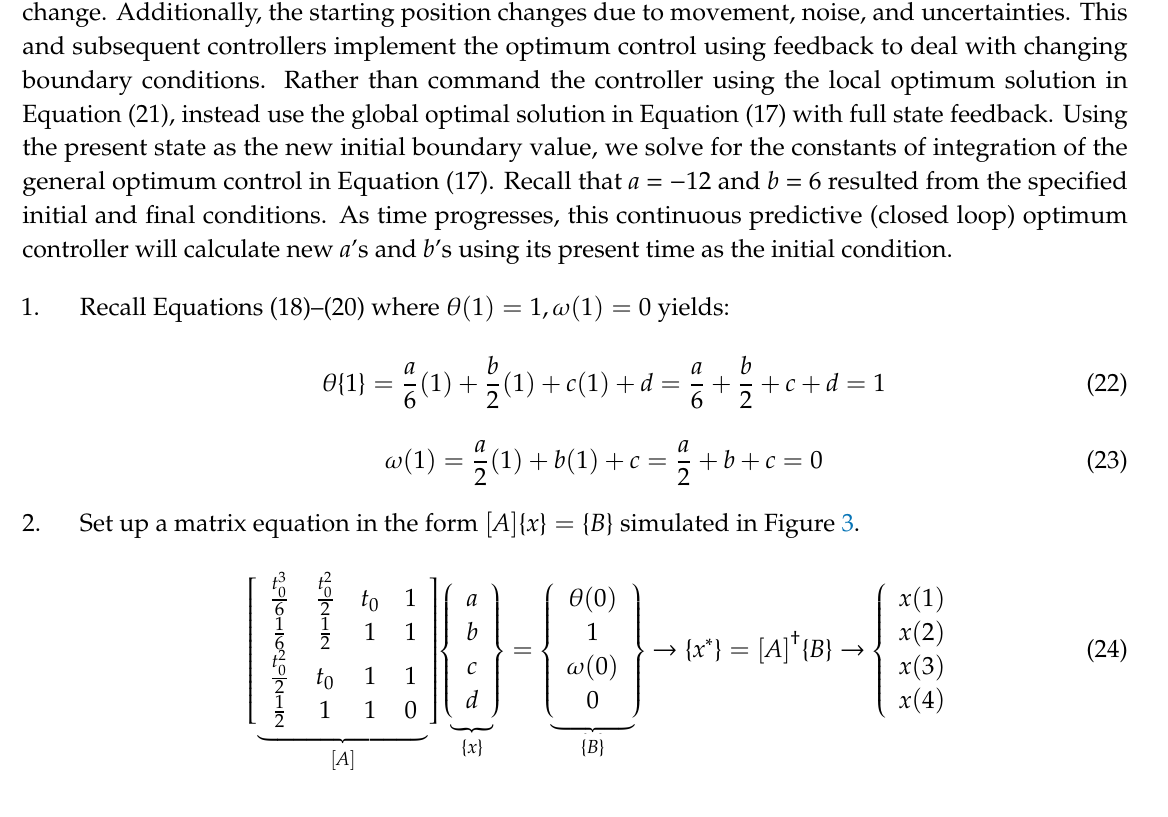
Figure 2. SIMULINK model of optimal controlled double integrator plant with noise added.